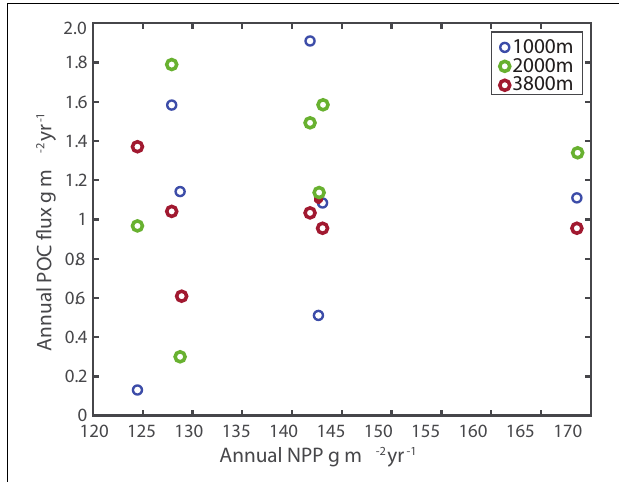
FIGURE 12 | Comparison of Annual POC flux and Annual NPP at SOTS. No statistical correlation was observed at any